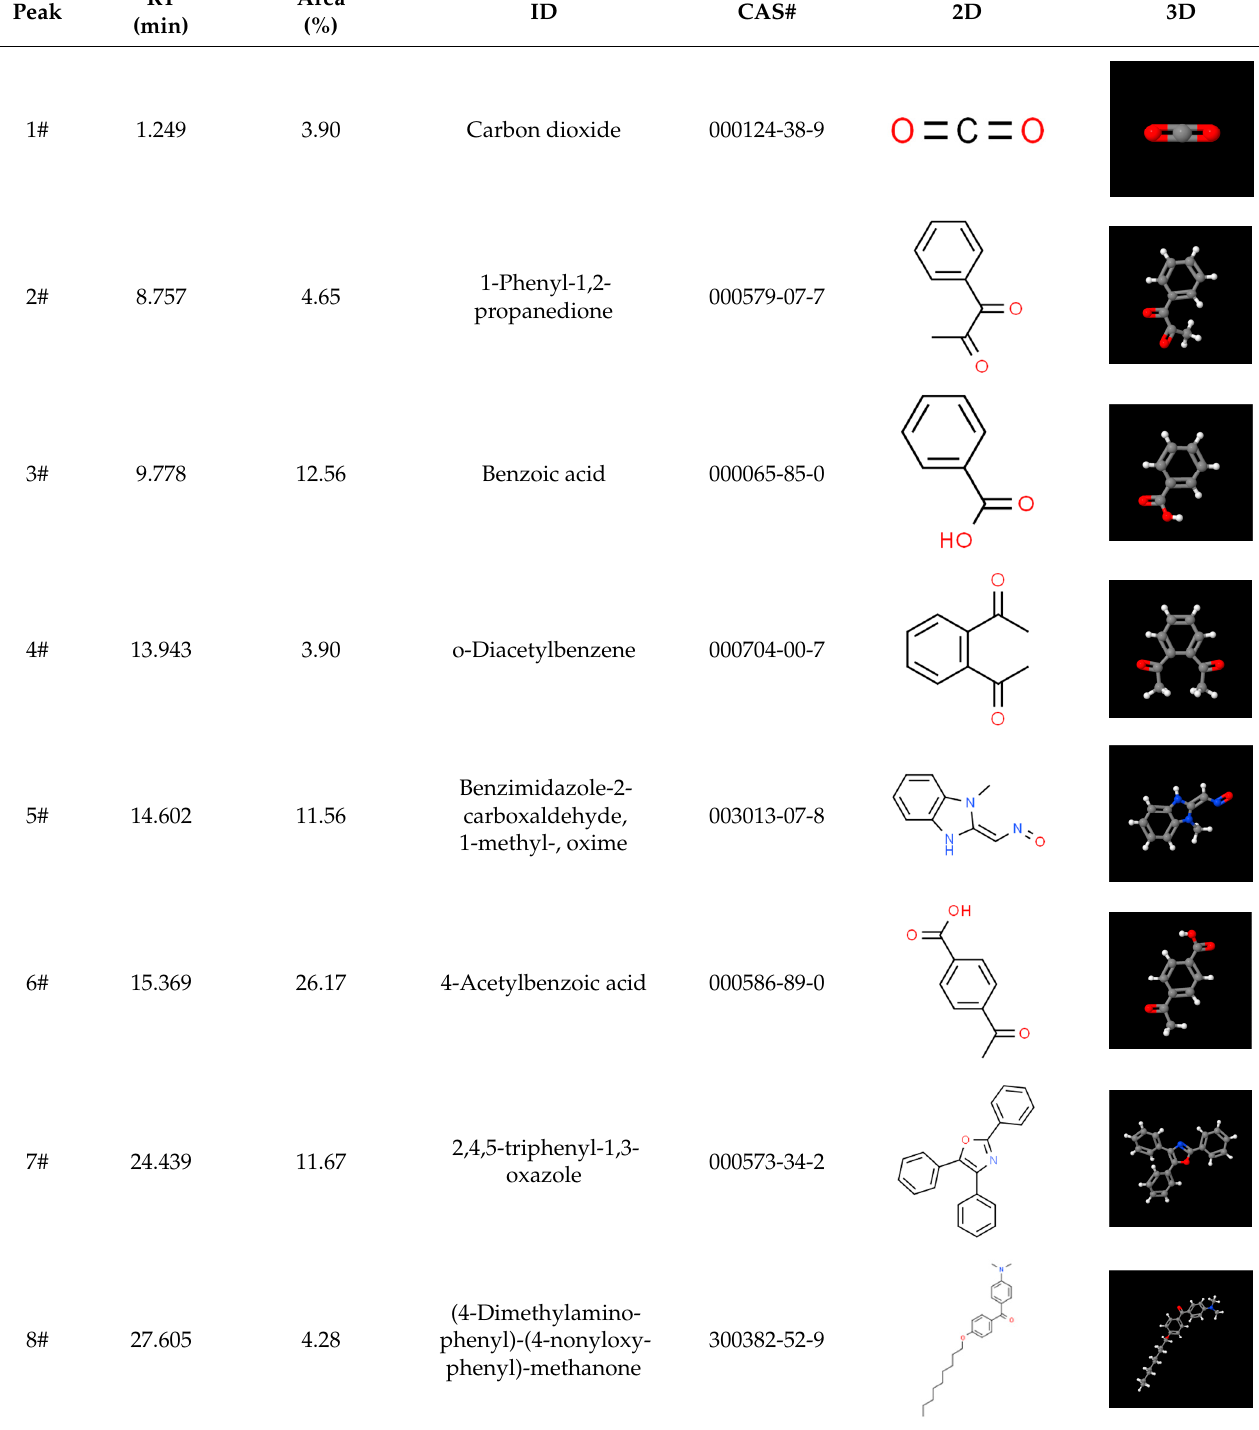
Figure 3. Ion current of evolved gaseous products during pyrolysis of PET film. Table 3. Composition table of the evolved gaseous products during pyrolysis of PET film.